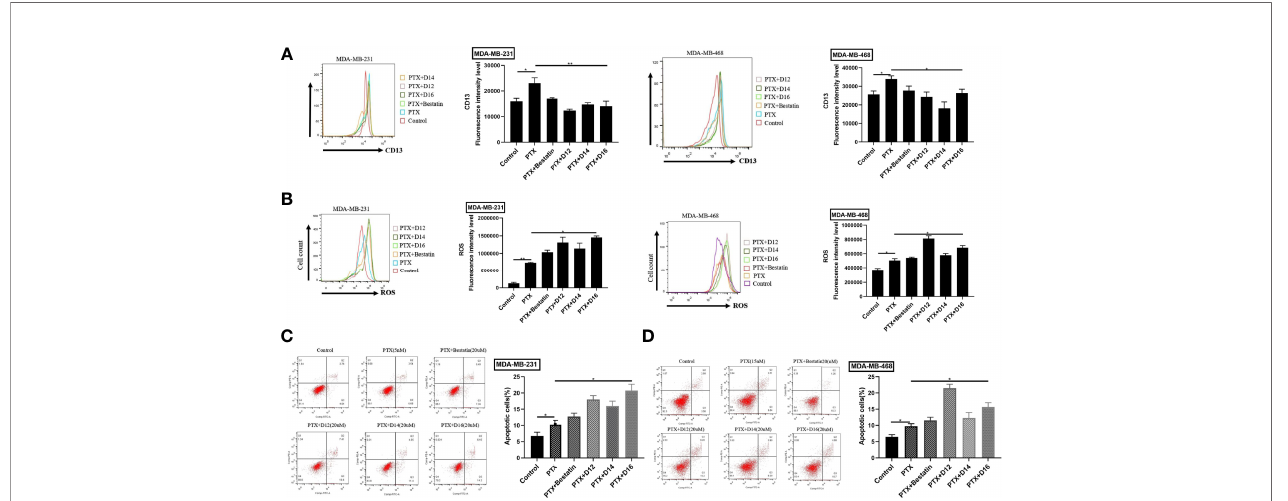
FIGURE 3 | Combination of APN inhibitors with PTX decreased the expression CD13 (APN), increased ROS level, and promoted cell apoptosis. (A) CD13 (APN) expression regulated by various PTX-APN inhibitor combinations; (B) ROS level monitored by various PTX-APN inhibitor combinations; (C) MDA-MB-231 cell apoptosis induced by different PTX-APN inhibitor combinations; (D) MDA-MB-468 cell apoptosis induced by different PTX-APN inhibitor combinations; *P ≤ 0.05, **P ≤